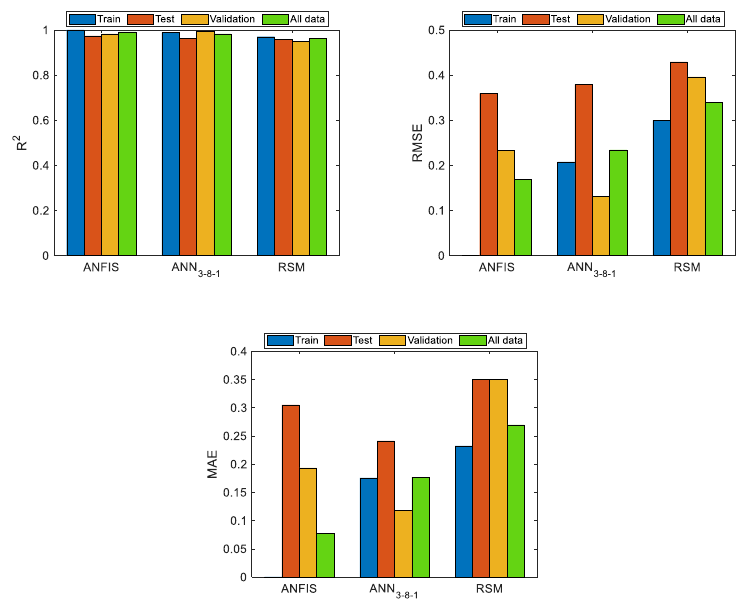
Figure 32. Difference between the actual values and those provided by the (Regression, ANN 3-8-1 and ANFIS) models for modeling Ra (μm) (Type 1 function). The data for obtaining these graphs have been taken from Ref. [61]).